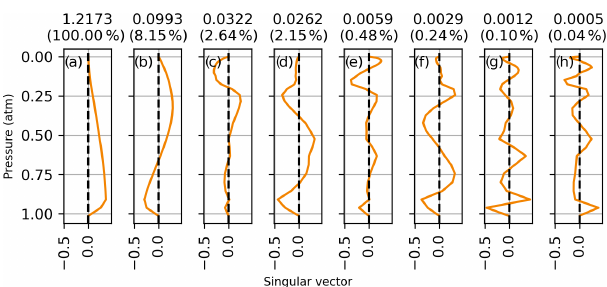
Figure D1. Right singular vector of the Jacobian associated with the eight largest singular values for profile retrievals from the Strong CO 2 window on 14 January 2012. The singular values are shown above each panel, and the singular value normalized to the largest singular value is shown in parenthesis.